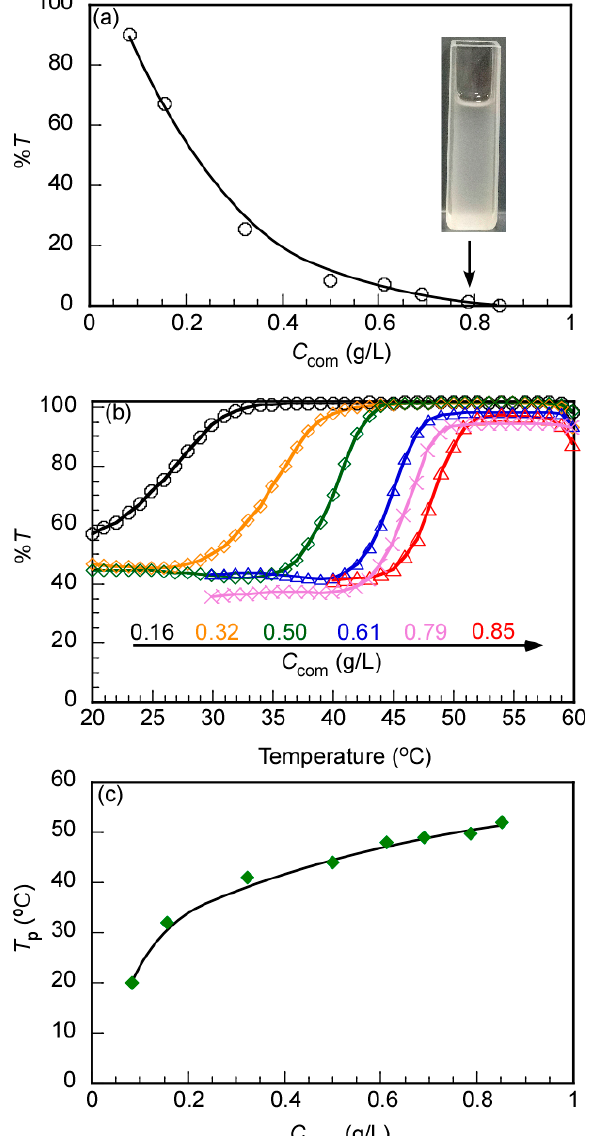
Figure 5. Percentage transmittance (% T ) of the 0.1 M NaCl aqueous PSBP/CTAB complex solutions at 25 °C with a mixing ratio of 0.5 as a function of ( a ) the complex concentration ( C com ) and ( b ) the temperature at different C com values of 0.16, 0.32, 0.50, 0.61, 0.79, and 0.85 g/L, and ( c ) the phase transition temperature ( T p ) dependant on C com for the PSBP/CTAB complex.